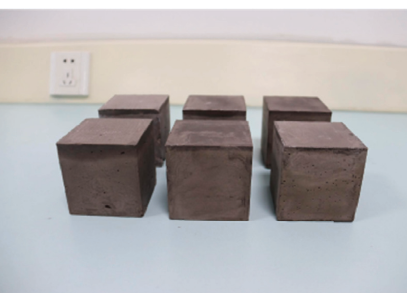
Figure 1: Some of the